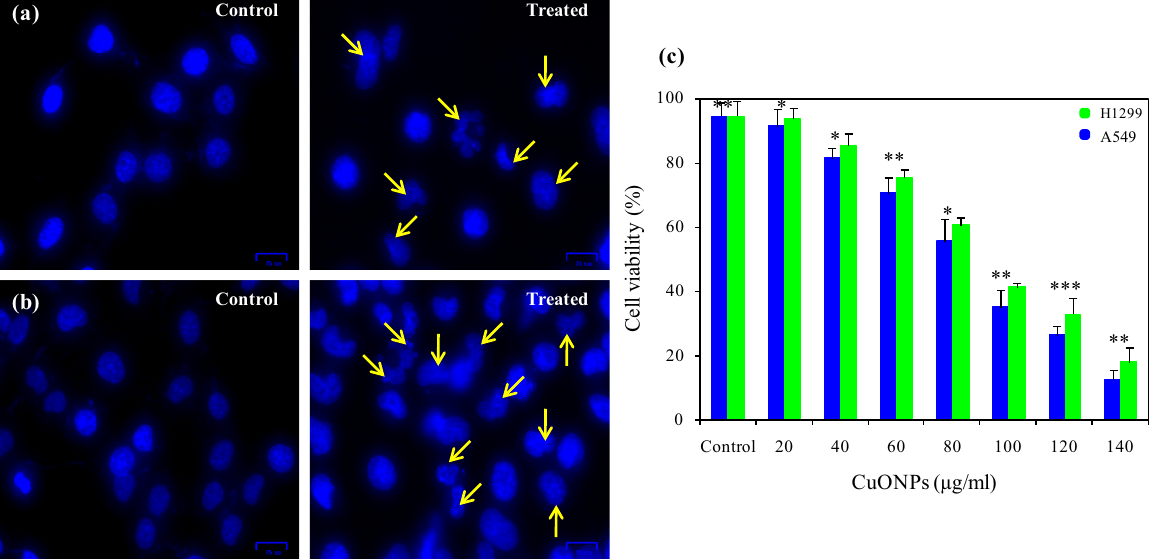
Figure 6. Cytotoxic effect of Phormidium derived CuONPs at IC50 concentration against lung cancer cell line ( a ) H1299 (control & treated); ( b ) A549 (control & treated); ( c ) cytotoxic effect of CuONPs against A549 & H1299 lung cancer cell lines at different concentration. Experiments were performed in triplicates; bars represent the mean of values and error bars represent mean ± SD (* P < 0.05).